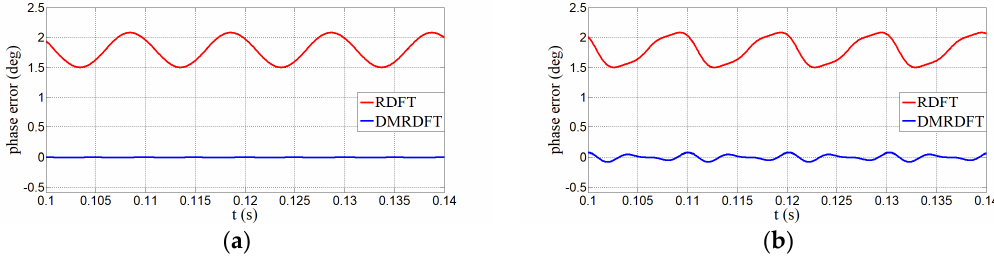
Figure 5. Steady performance comparison of grid voltage phase tracking: ( a ) performance when without harmonic, and ( b ) performance when with harmonic.